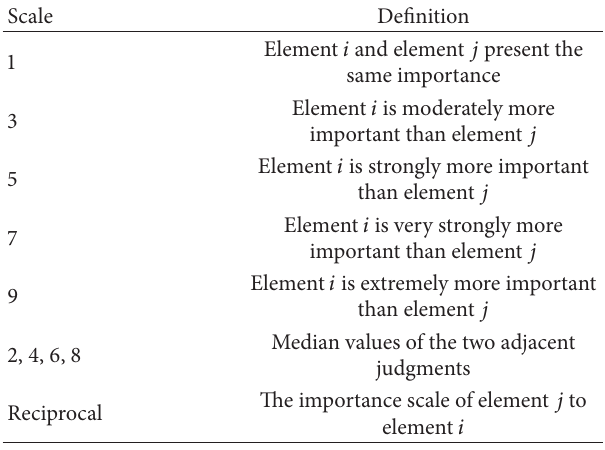
Table 2: Scale method of 1–9 in